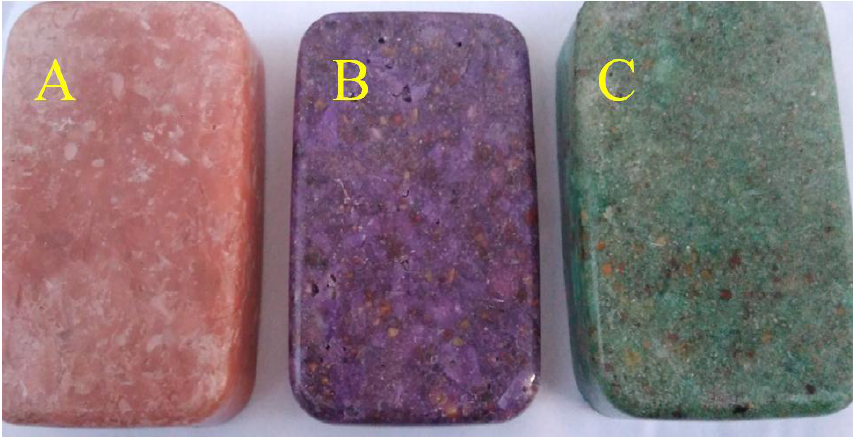
Figure 10. Aesthetics of the Polymer Concretes with Different RGA Content: ( a ) CG-100; ( b ) CG-50; ( c ) CG-30.